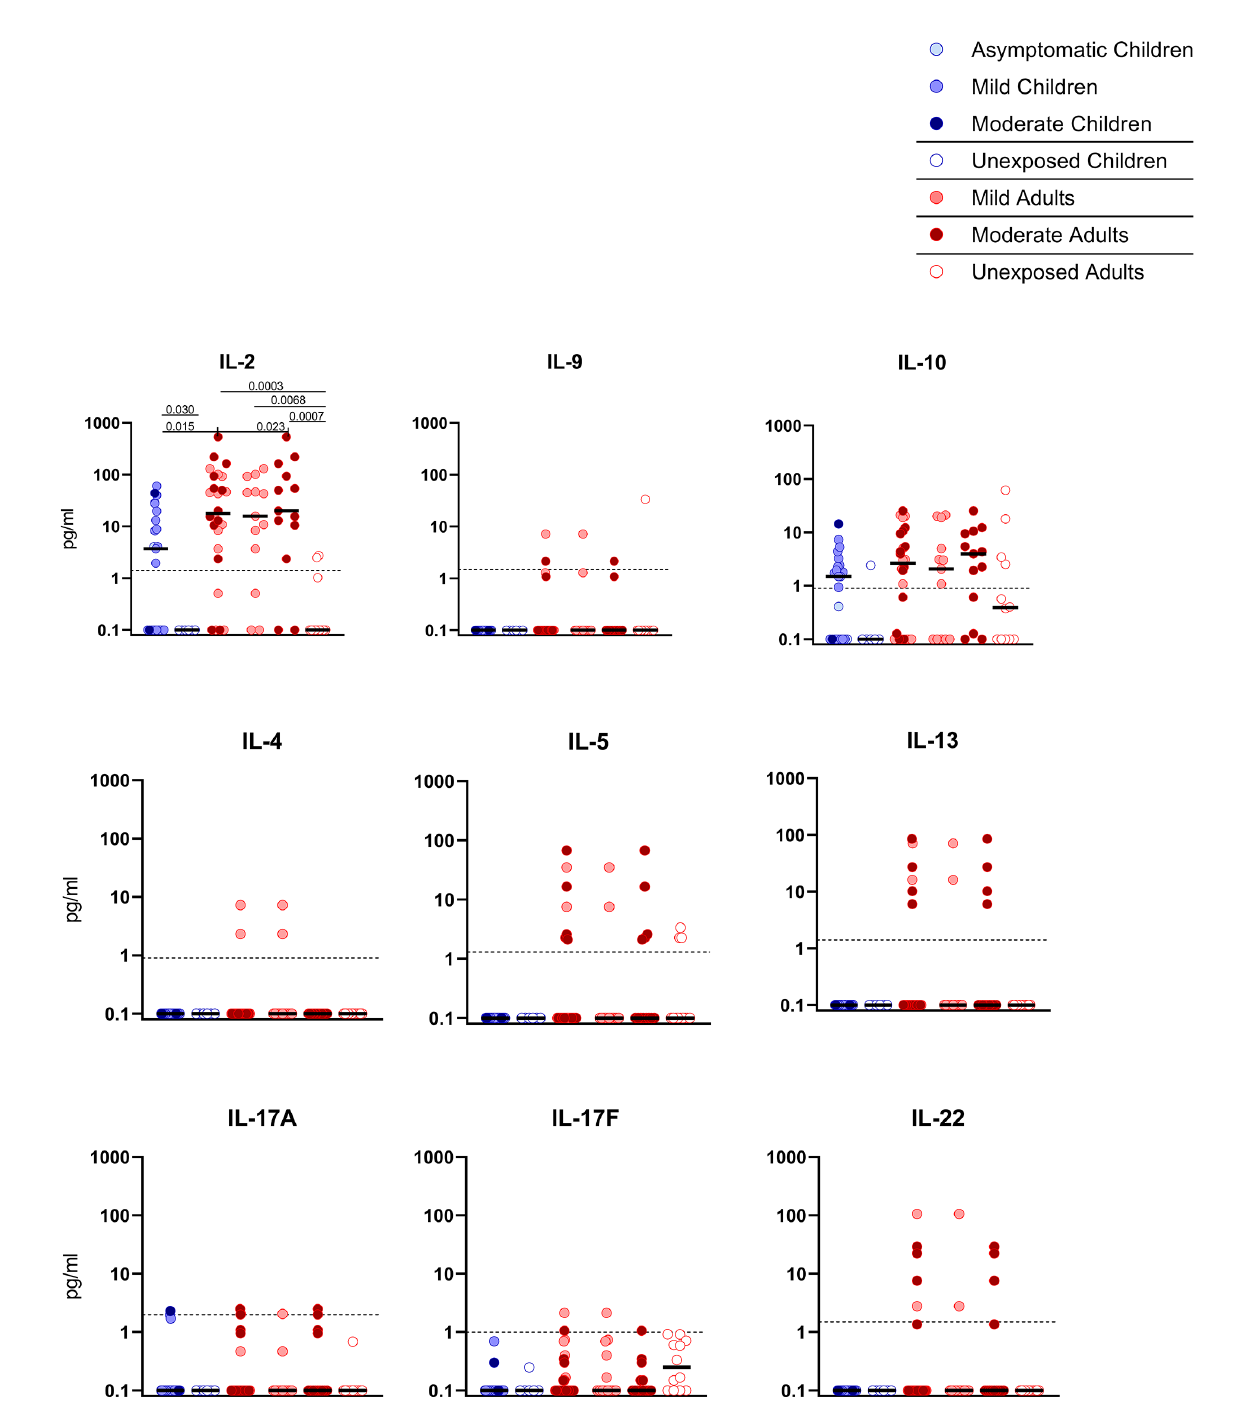
FIGURE 4 | Cytokine release in infected children and mild versus moderate symptomatic adults over time after infection. Cell-free culture supernatants were harvested from IFN- ɣ ELISPOT plates and the release of the following cytokines was measured in T1 samples: IL-2, IL-4, IL-5, IL-9, IL-10, IL-13, IL-17A, IL-17F, IL- 22. Dot plots show the concentration of cytokines (pg/ml) after stimulation of PBMCs with a set of overlapping peptides of SARS-CoV-2 spike protein. Infected children and unexposed children versus infected adults with mild or moderate disease and unexposed adults are depicted. Minimum detection threshold (MDT) concentrations for each cytokine, as calculated by the manufacturer and mentioned in the Material and Methods section, are indicated with horizontal dotted lines. Each dot represents one subject. Bars indicate the median cytokine concentration (pg/ml). For two-group comparisons (infected children versus unexposed children), Mann-Whitney U test was used. Kruskal-Wallis rank-sum test with Dunn ’ s post hoc test for multiple comparisons was used (all adults versus mild adults versus moderate adults versus unexposed adults; all adults versus mild adults versus moderate adults versus infected children). P-values ≤ 0.05 are